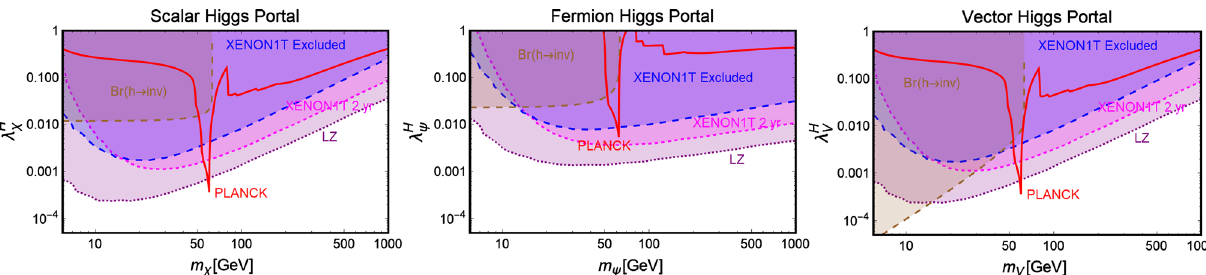
excluded in case of absence of signals in XENON1T after 2 years of exposure time while the purple region is within the reach of future LZ limits.Finally,thebrownregionisexcludedbecauseofaexperimentally disfavored invisible decay branching fraction of the SM-Higgs